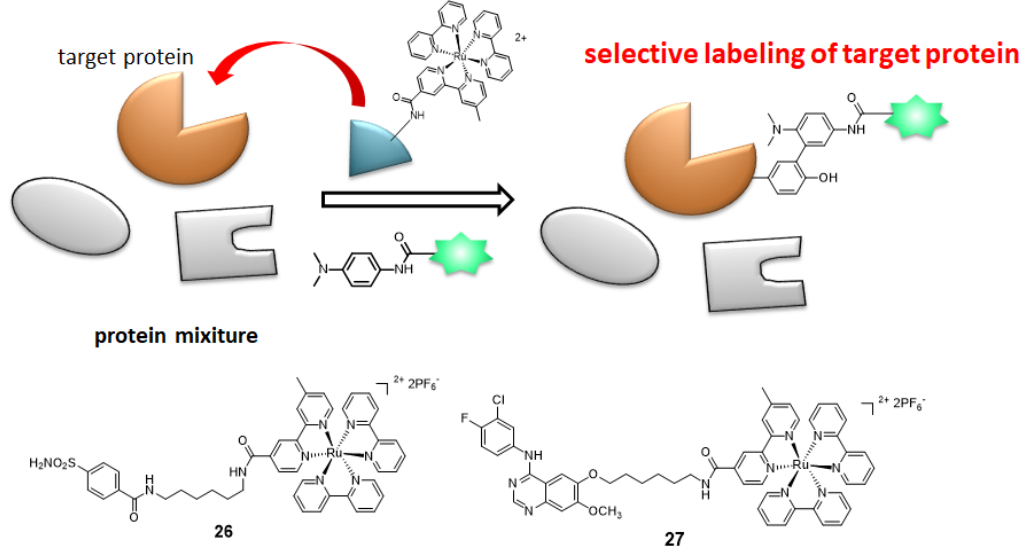
Figure 8. Target selective labeling by proximity labeling using ligand-conjugated photocatalysts 26 and 27 .